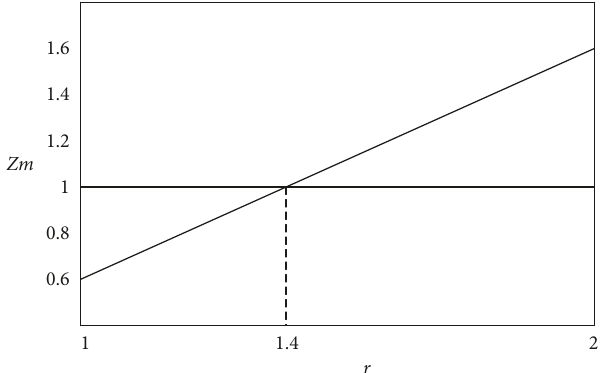
Figure 2: Turing bifurcation with critical point 𝑟 ’ ≈